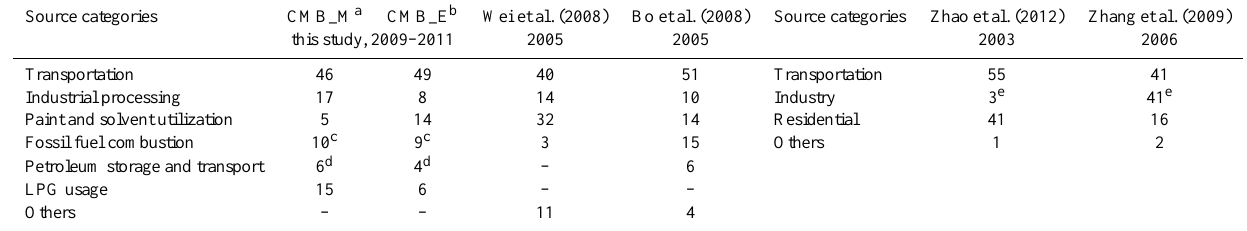
Table 1. Comparison of the relative contributions (%) of anthropogenic sources of NMVOC emissions in Beijing calculated by the CMB model in this study and results from bottom-up emission